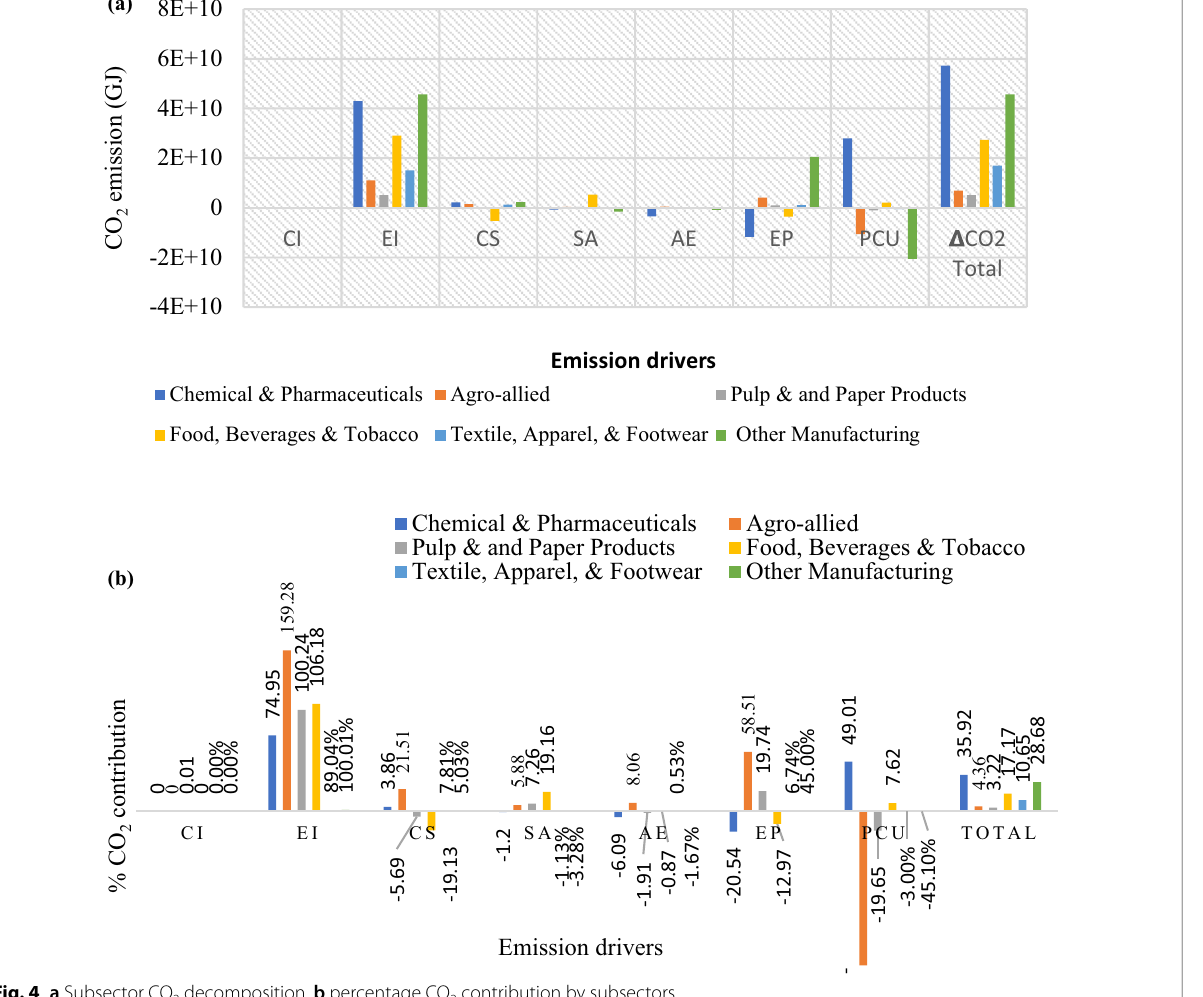
Fig. 4 a Subsector CO 2 decomposition, b percentage CO 2 contribution by subsectors